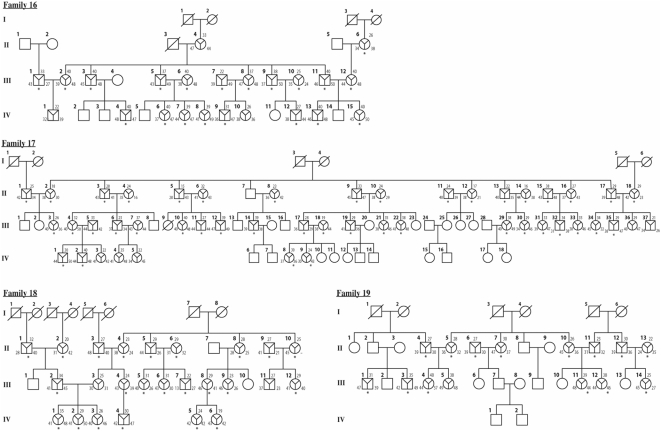
The pedigrees 16–19 participating in the study.Upper triangle, test score for KMT; left, test score for ST; right, test score for SP. Subjects who had given DNA for the genome-wide scan are marked by an asterisk (*).